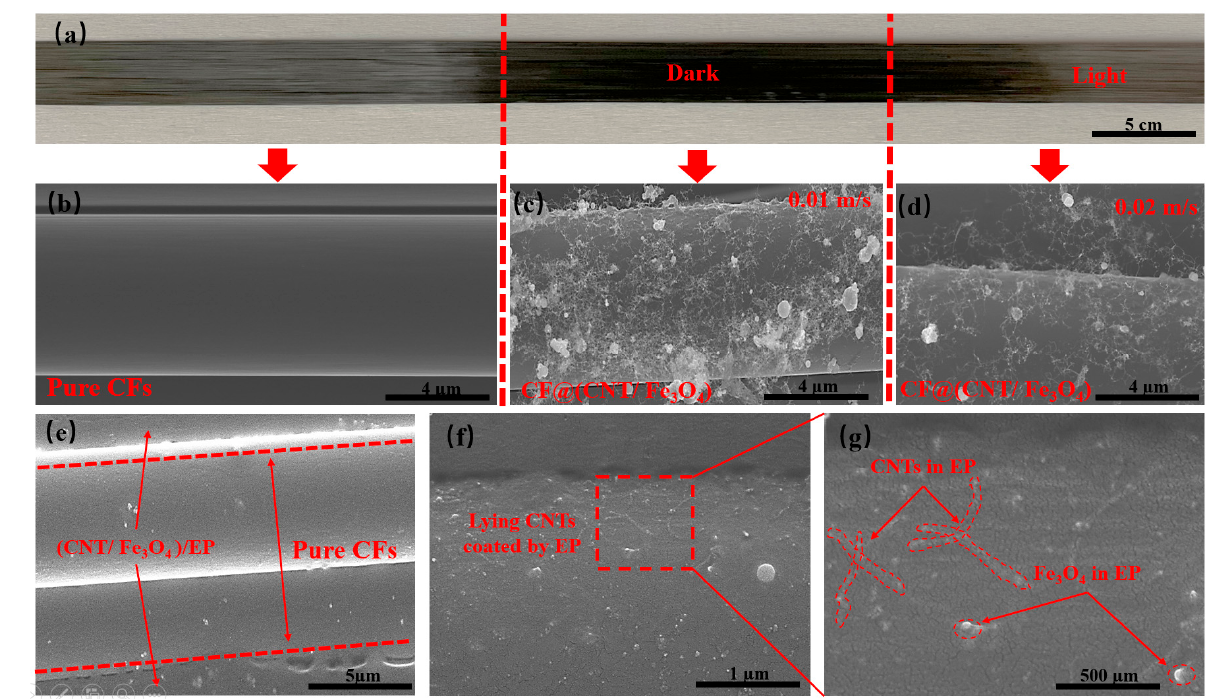
2D planar structure, which is conducive to maintaining the insulation between CFs layers. Figure 2. ( a ) Pure CFs at the left, CF@(CNT/Fe3O4) with high content CNT/Fe3O4 at middle, and Figure 2. ( a ) Pure CFs at the left, CF@(CNT/Fe 3 O 4 ) with high content CNT/Fe 3 O 4 at mid- low content CNT/Fe3O4 at right. ( b ) SEM of pure CFs. ( c ) CF@(CNT/Fe3O4) with no rolling and dle, and low content CNT/Fe 3 O 4 at right. ( b ) SEM of pure CFs. ( c ) CF@(CNT/Fe 3 O 4 ) with high content CNT/Fe3O4, and ( d ) with no rolling and low content CNT/Fe3O4. ( e ) no rolling and high content CNT/Fe 3 O 4 , and ( d ) with no rolling and low content CNT/Fe 3 O 4 . CF@(CNT/Fe3O4)/EP with rolled treatment, CFs in the middle and CF@(CNT/Fe3O4) on both sides. ( e ) CF@(CNT/Fe 3 O 4 )/EP with rolled treatment, CFs in the middle and CF@(CNT/Fe 3 O 4 ) on both ( f , g ) CF@(CNT/Fe3O4)/EP locally enlarged image; lying CNTs are coated by EP. sides. ( f , g ) CF@(CNT/Fe 3 O 4 )/EP locally enlarged image; lying CNTs are coated by Considering that CNTs and Fe 3 O 4 may change their properties under the action of free arc, Fe 3 O 4 may be converted into Fe 2 O 3 at high temperature [47]. The Raman of CNT/Fe 3 O 4 dispersion fog obtained using the free arc dispersion method is compared with pure CNTs (Figure 3a). CNT/Fe 3 O 4 dispersion fog has characteristic peaks at 1341 cm − 1 (D- line) and 1578 cm − 1 (G-line), which are the characteristic peaks of carbonaceous com- pounds [48,49]; this parameter complies with the CNT standard spectrum. In addition, the I D /I G values of CNTs/Fe 3 O 4 and CNTs are 1.15 and 1.12, respectively; this indicates that the graphitization degree of CNTs is not affected by the free arc. Figure 3b shows the comparison of CNT/Fe 3 O 4 dispersion fog Raman image and Fe 3 O 4 standard spectrum, and the result is also consistent [50,51]. It demonstrated that the structure of CNTs and Fe 3 O 4 do not change, and CNT/Fe 3 O 4 dispersion fog has a higher purity, only containing CNTs and Fe 3 O 4 ; there are no other substances. XRD image (Figure 3c) shows that the diffraction peaks of CNTs and Fe 3 O 4 are in good agreement with CNT/Fe 3 O 4 dispersion fog, respec- tively; there are corresponding diffraction peaks at particular diffraction angles [52,53]. The above characterizations indicate that CNTs and Fe 3 O 4 maintain good material struc- ture during free arc dispersion and spraying.